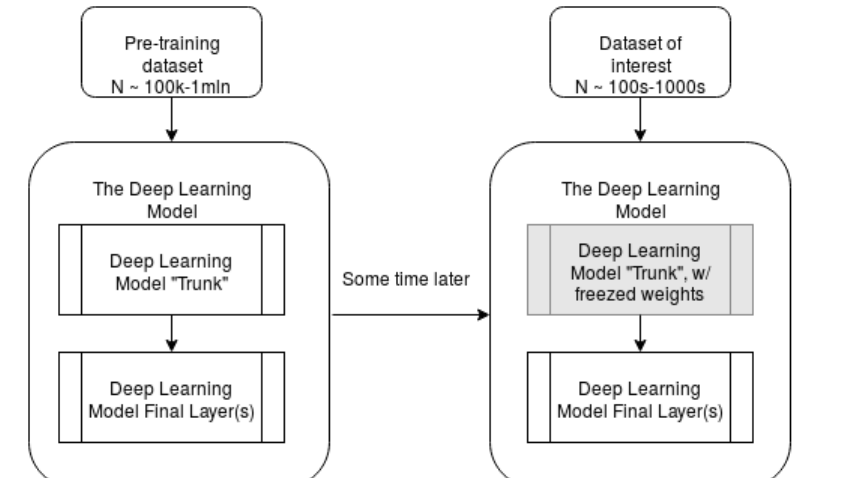
Figure 1. General view of the Transfer Learning process where the left hand side shows the required pre-trained neural network and the right hand side the fine-tuning process.